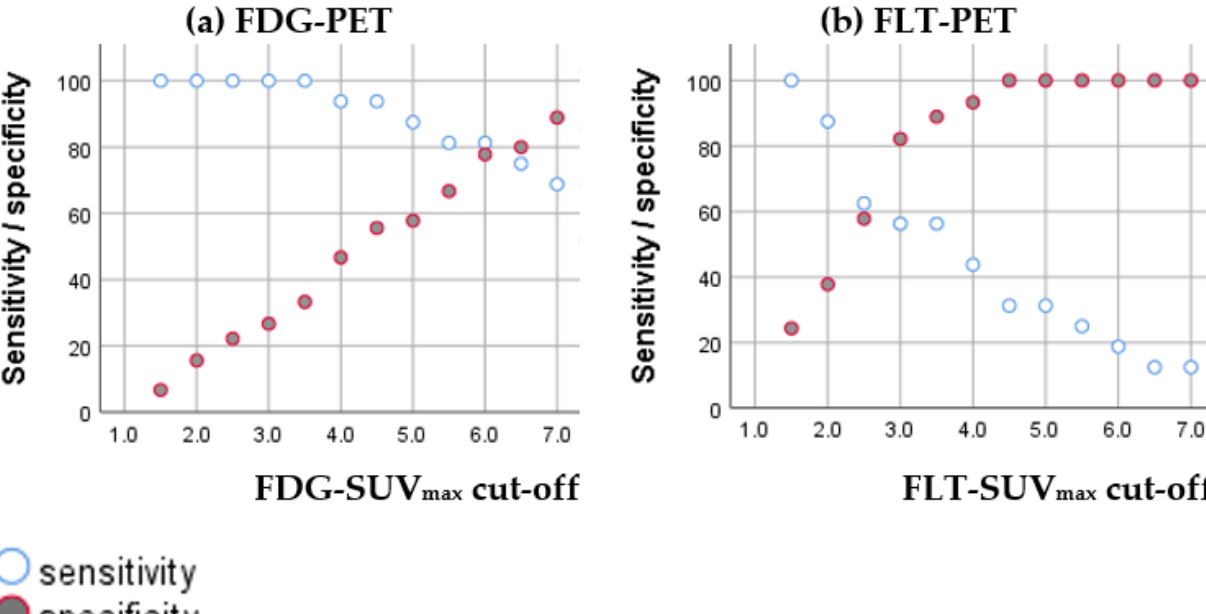
Figure 7. Scatter plot of sensitivity and specificity of FDG-SUV max ( a ) and FLT-SUV max ( b ) in HDV with variable cutoffs.